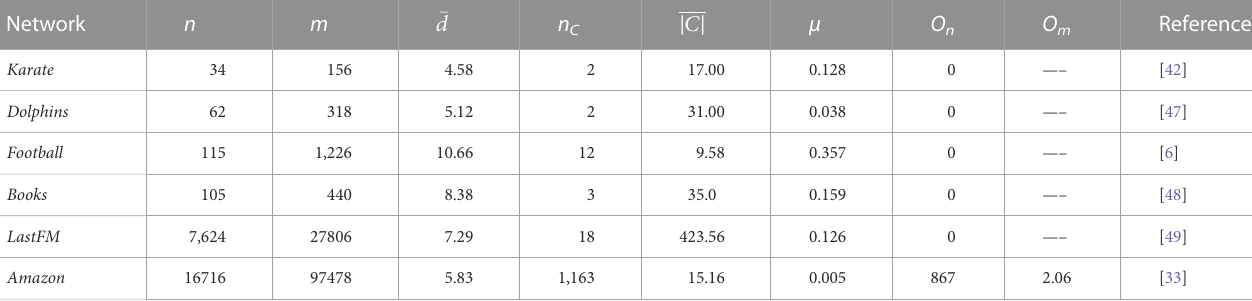
TABLE 4 The characteristics of real-world